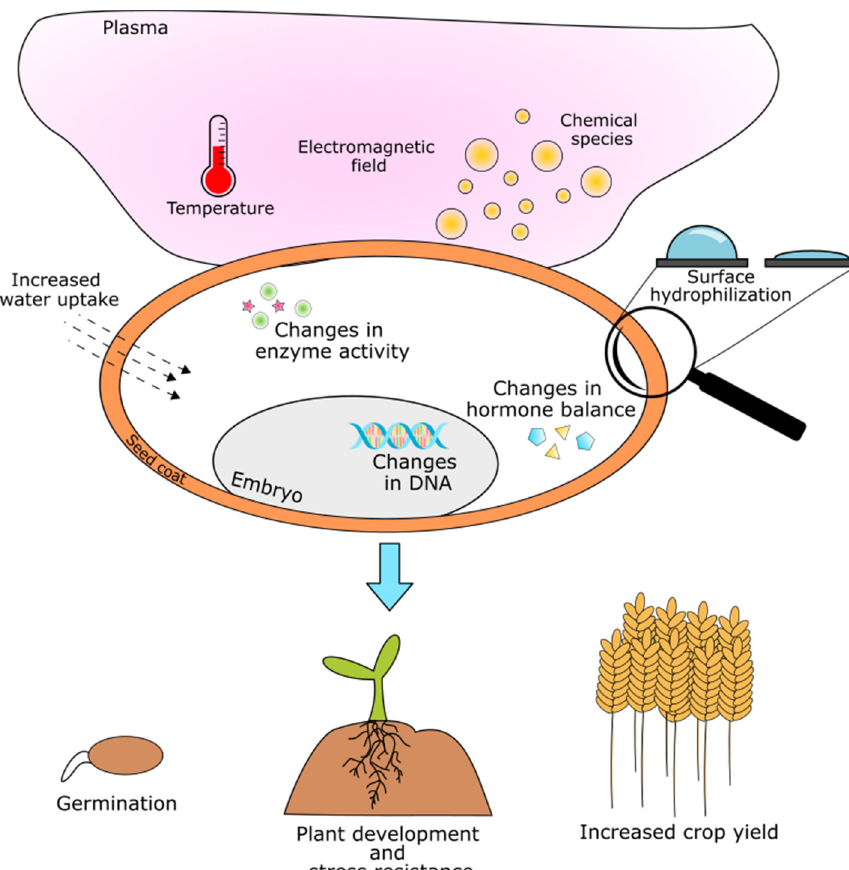
Figure 1. A schematic representation of nonthermal plasma (NTP) effects on seeds. Table 1. An overview of experimental cold plasma parameters and their e ff ects on di ff erent seeds. DBD: dielectric. DCSBD: di ff use coplanar surface barrier discharge. RF-CCP: radio frequency